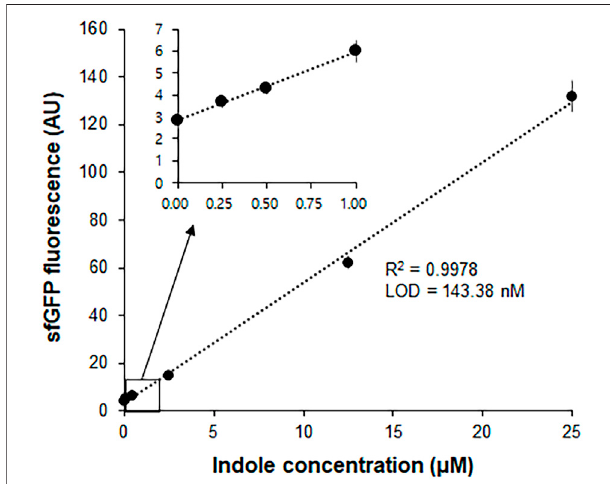
FIGURE 4 | Measurement of indole by Indole-CCPFS assay employing Pf TrpB-enriched S12 extract. The S12 extract was prepared after overexpressionofthe Pf TrpBenzymeduringthecultivationof E.coli cells. The resulting Pf TrpB-enriched S12 extract was dia fi ltered to remove residual amino acids prior to its use for Indole-CCFPS assay programmed with the template DNA encoding sfGFP. Indole-CCFPS assay was performed with varying concentrations of indole, and measured for the fl uorescence of synthesized sfGFP. Inset represents the enlarged graph of the boxed region. Measurements were performed in triplicate, and the error bars represent the standard deviations of three independent